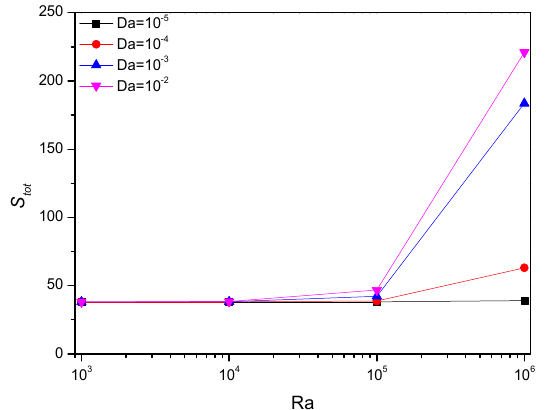
Figure 12. Total entropy as a function of Rayleigh number (Ra) at various values of Darcy number (Da). Ha = 0, φ = 0.02 and ε p = 0.4 .